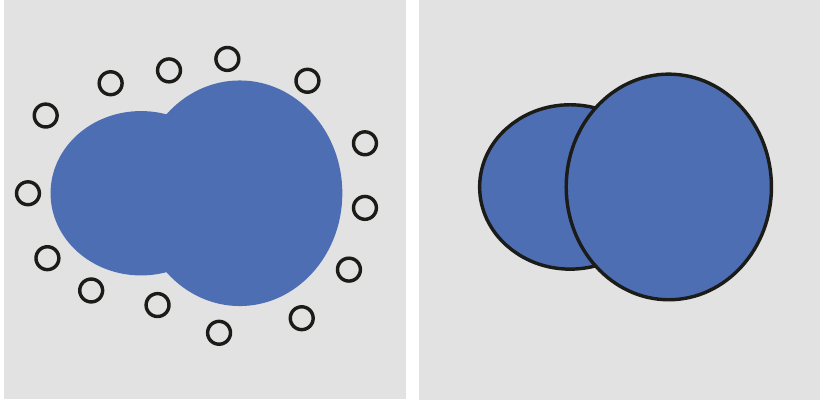
Figure 2: Schematic diagram of segmentation of parametric active contour